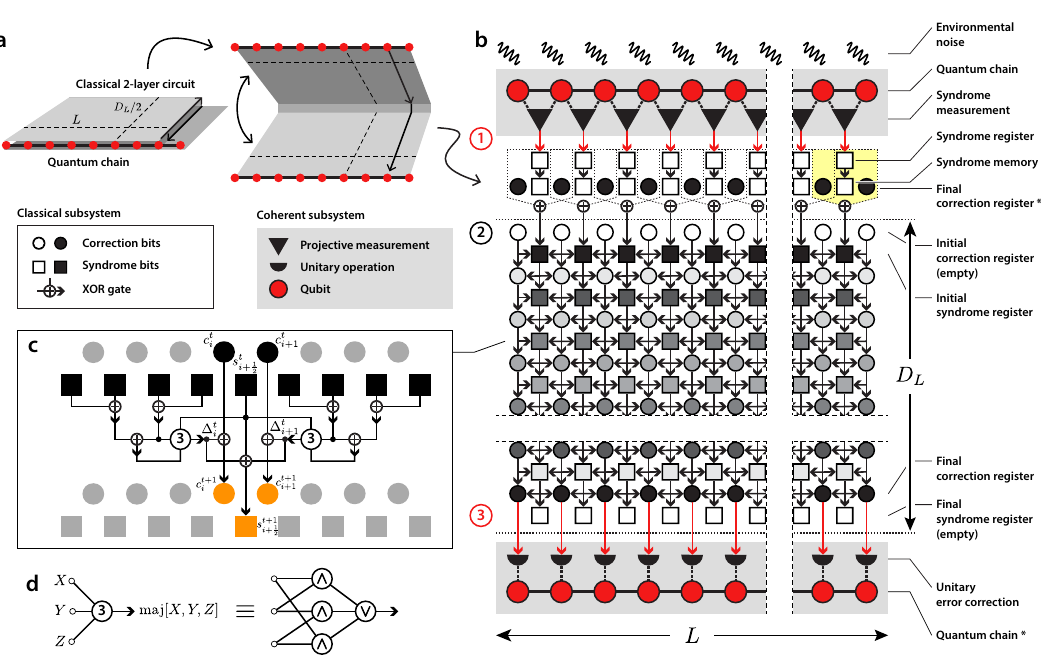
Figure 9: 2D-evolved TLV . a The quantum chain is placed on top and framed by a 2D substrate that allows for the implementation of classical two-layer circuitry (e.g., by photo lithography) that connects to projective (measurement-) and unitary gates along the chain. The classical circuits are used to pro- cess measurement results and control unitary gates in an integrated, scalable fashion. For illustrative purposes, the two layers are drawn unfolded with a copy of the quantum chain at top and bottom. The length of the chain is L and the depth of the (unfolded) circuit is denoted by D , the scaling of which L is discussed in the text. b Detailed setup to fight continuous noise on the quantum chain. Information propagates in a feed-forward manner from top (syndrome measurements) to bottom (correction op- erations). At the beginning of each time step, the syndrome pattern from projective measurements is fed into the syndrome register (Substep 1, red arrows). Subsequently, the content of all horizon- tal registers is evolved to the next layer (Substep 2, black arrows). Finally, the results in the final correction register are applied to the quantum chain (Substep 3, red arrows). The initial syndrome register is fed by the parity of syndrome memory , syndrome register and the syn- drome of the last applied correction in the final correction register (indicated by the yellow box). The shading of classical bits (squares and circles) from black to white (or vice versa) illustrates the typical operation of the circuit: The syndrome register starts off in a non-empty state at the top whereas the cumulative correction register is initialized with all bits zero. Propagation to the bottom transforms the correction register into the non-trivial result of the decoding proce- dure while depleting the syndrome register . The latter reaches an empty state at the bottom (with high probability, see text). The elements marked by (*) are drawn twice for illustrative purposes and exist only once in hardware (see a ). c Detailed logical flow in the scalable bulk that defines the new state of the next row in dependence of the state of the last row. The shown operations implement the evolution of TLV in syndrome-delta representation directly on the syndrome registers (squares) while accumulating all applied operations on the qubits in the correction registers (circles). Note that actual qubit rotations are only applied once at the bottom, defined by the state of the final = c ( t ) etc. as compared to the text. correction register . For the sake of compactness, we write c t i i d Besides the ubiquitous XOR -gates, the only additional gate required is the majority gate with three inputs ( MAJ3 -gate) which can be easily translated into a network of elementary AND - and OR